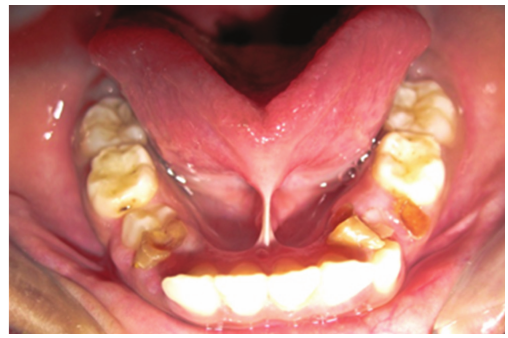
F 2: Preoperative photograph (Case